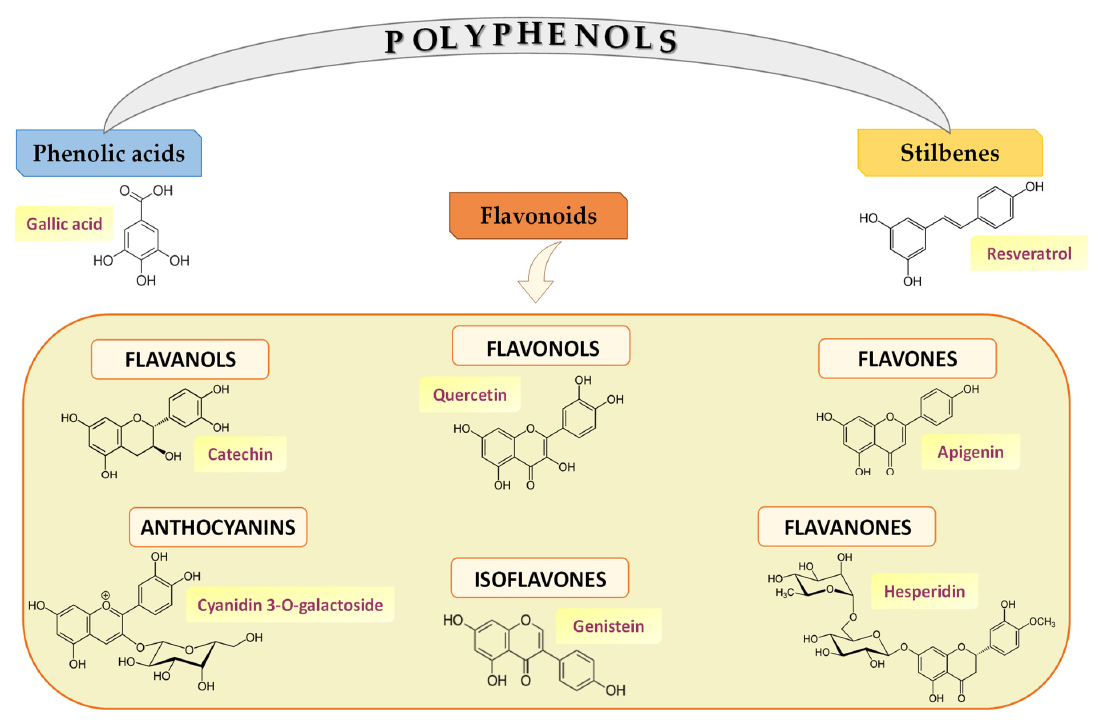
Figure 2. Polyphenol classes and chemical structures of some of their main compounds. Flavonols—including quercetin and kaempferol—are the most representative compounds of foods such as onions, cabbage, leeks, broccoli, blueberries, tea, and red